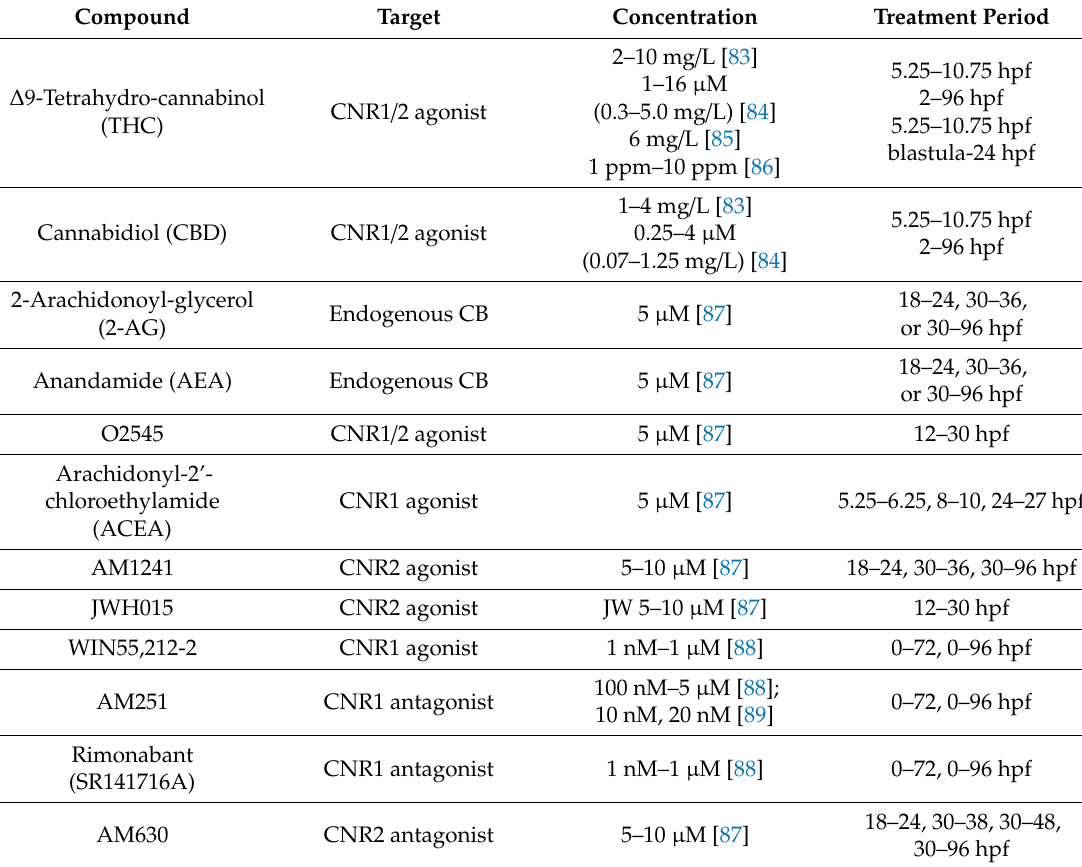
Table 3. Cannabinoid signaling modulators used in zebrafish studies and the treatment period during development. Compound Target Concentration Treatment